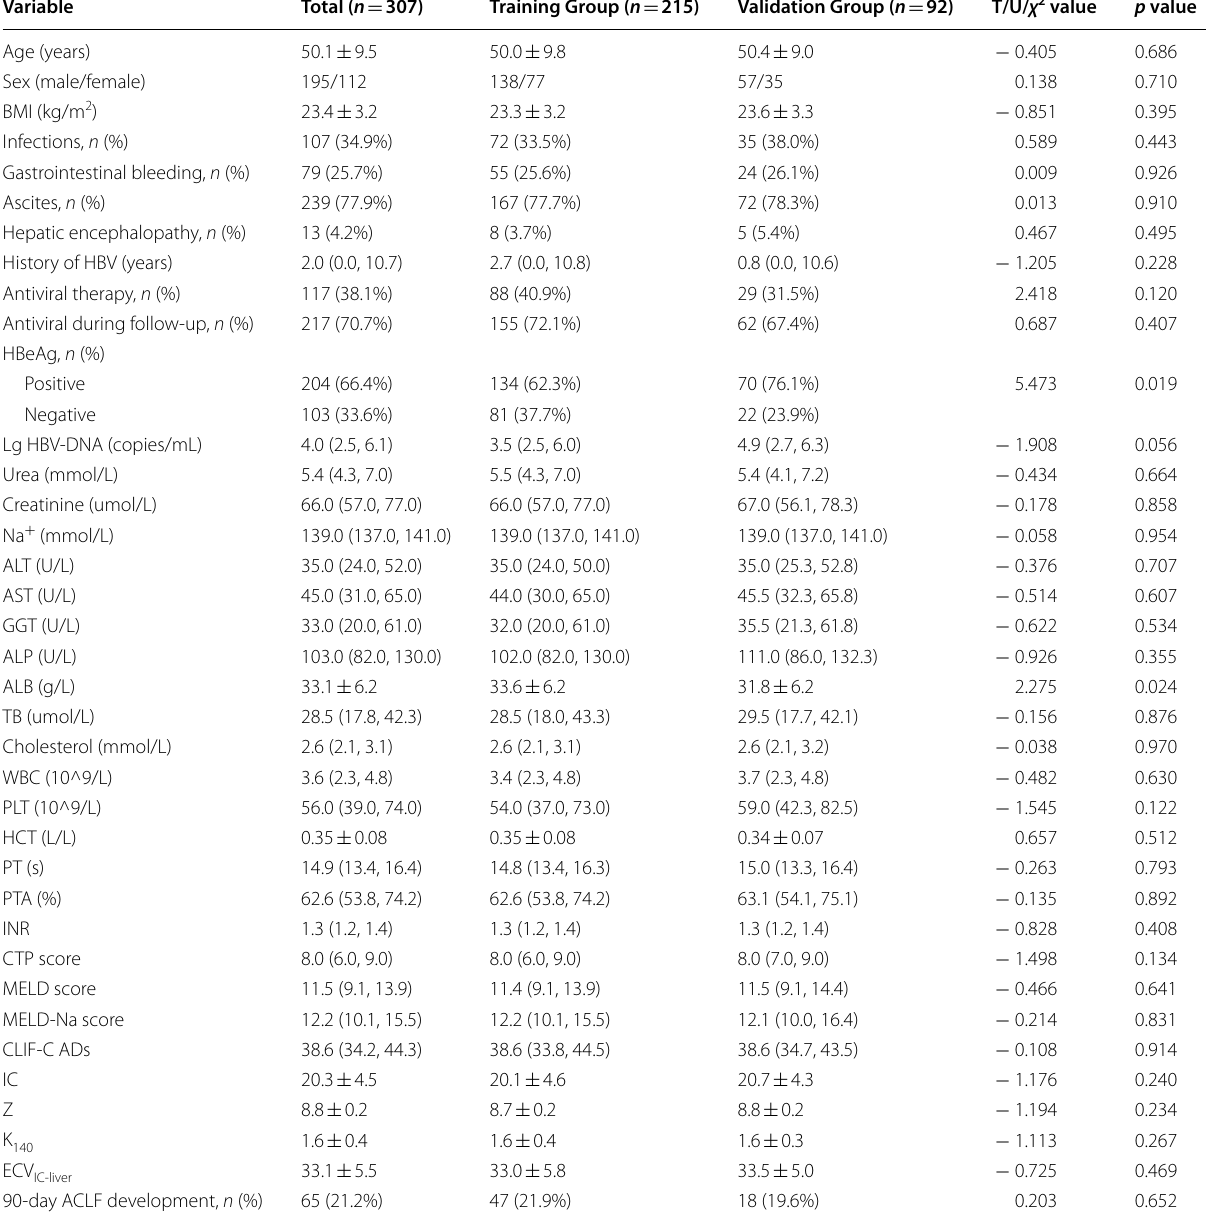
Table 1 Clinical characteristics, laboratory indices and equilibrium phase dual-energy CT parameters of patients in the training and validation